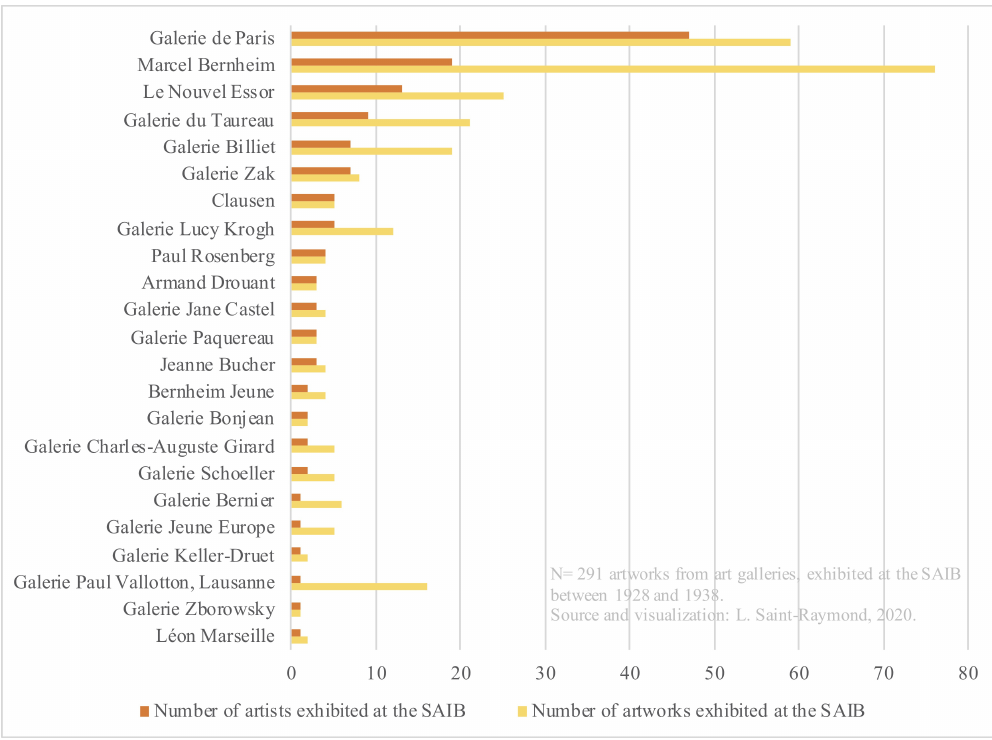
Figure 7. List of the art galleries that sent artworks to the SAIB from 1928 through